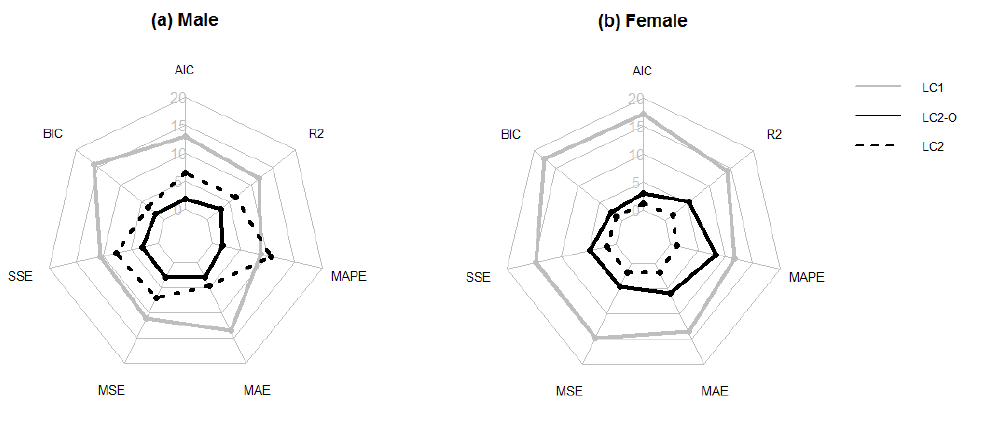
Figure 6. Radar graph that summarizing the number of countries for which each model (LC, LC2, and LC2-O) achieves the best forecasting ability according to the 5-fold CV method for males ( a ) and females ( b